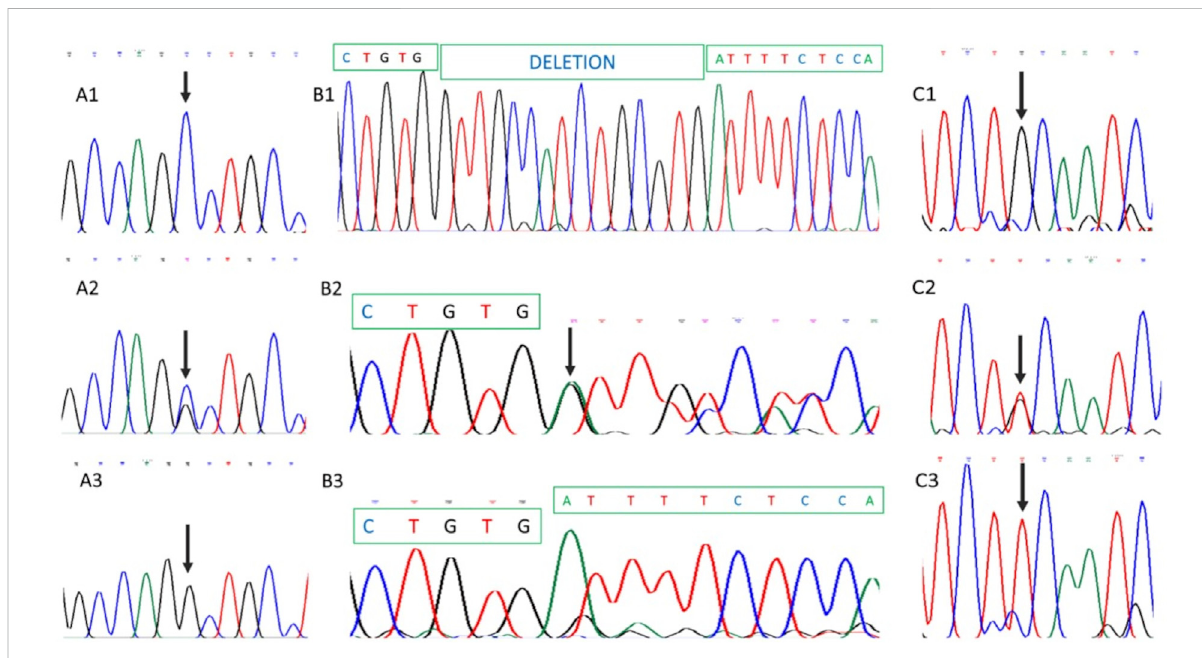
FIGURE 4 Partial DNASanger sequencing of ABCA 4and USH2A genes. (A1) , (B1) , and (C1) show partial DNA sequences from thehealthy mother. (A1) and (A2) correspond to ABCA4 partial sequences, while (C1) shows the USH2A sequence. As shown, no pathogenic variants were identi fi ed in maternal DNA. (A2) , (B2), and (C2) show paternal DNA analysis demonstrating heterozygosity for ABCA4 and USH2A pathogenic variants. (A3) , (B3), and (C3) show homozygosity for ABCA4 (A3 and B3) and USH2A (C3) mutations in proband ’ s DNA. Involved nucleotides are